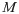
Hierarchical clustering of 15 gene signature used by model M to classify disease status.A clear separation is observed between IPF and normal patient samples. Note that this is just for visualization purposes, and M uses logistic regression to classify samples, not clustering. Row-scaled log intensity units are plotted. We use the complete linkage method for hierarchical clustering with a Euclidean distance measure.